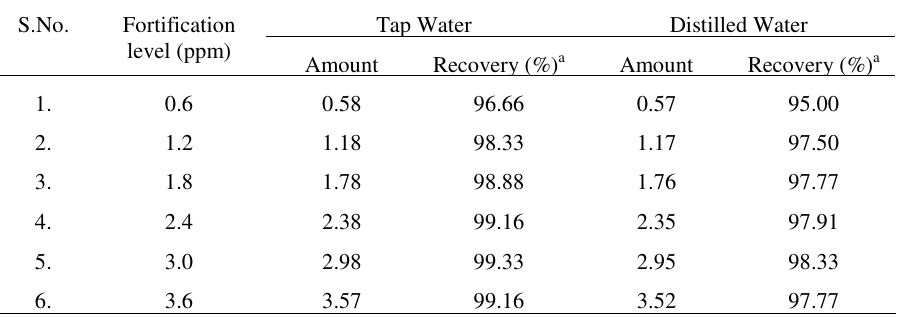
Tap Water Distilled Water S.No.